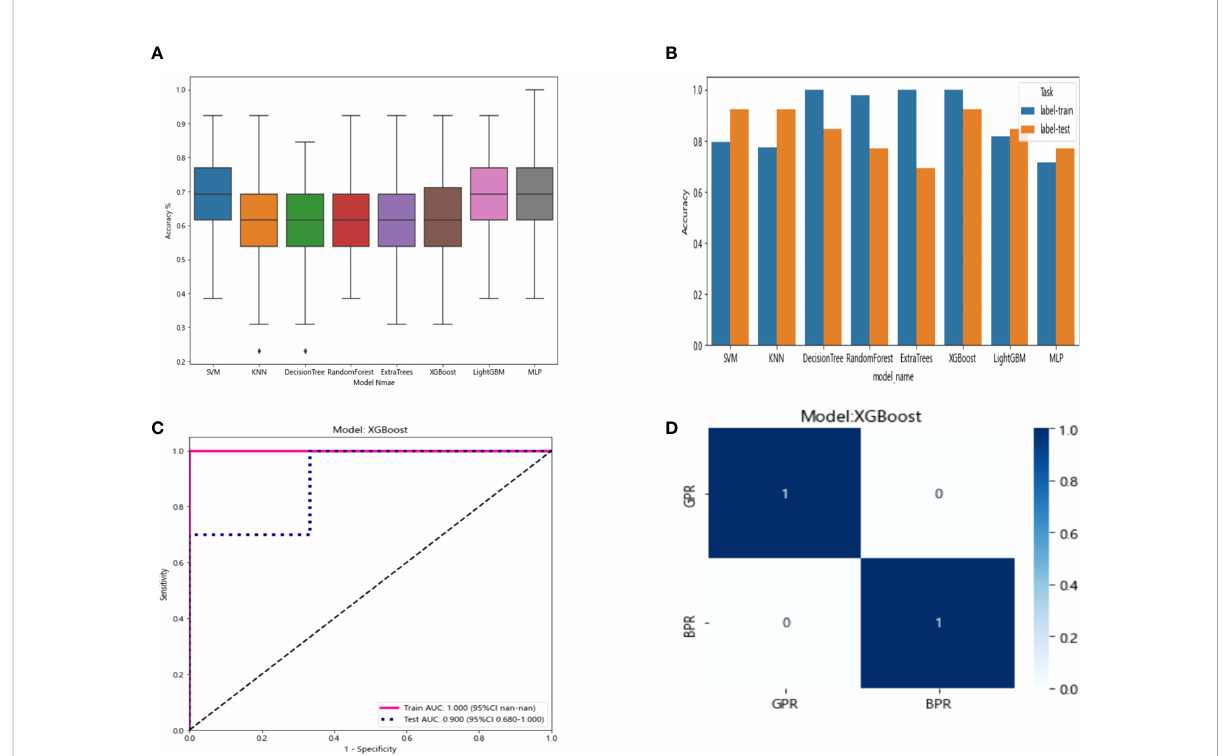
FIGURE 9 (A) Distribution of the accuracy of each model randomly tested 100 times by eight common machine learning algorithms. (B) Comparison of the accuracy of the best performing one out of 100 randomizations in eight machine learning algorithms. (C) AUCs of the training set and test set in the XGBoost model. (D) Confusion matrix for the XGBoost model.